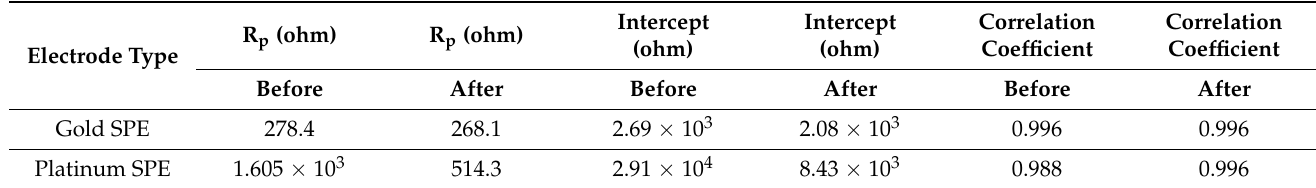
Figure 10. EIS of the gold and platinum electrodes before and after electrochemical cleaning: blue-EIS before electrochemical cleaning; red-EIS after electrochemical cleaning. Created with OriginPro . The EIS measurements performed in the frequency range of 0.1 m Hz to 100 kHz, in an alternating current with an amplitude of 10 mV are presented in Table 8, for the Nyquist diagrams obtained before and after the electrochemical cleaning. Table 8. EIS measurements before and after the electrochemical cleaning .